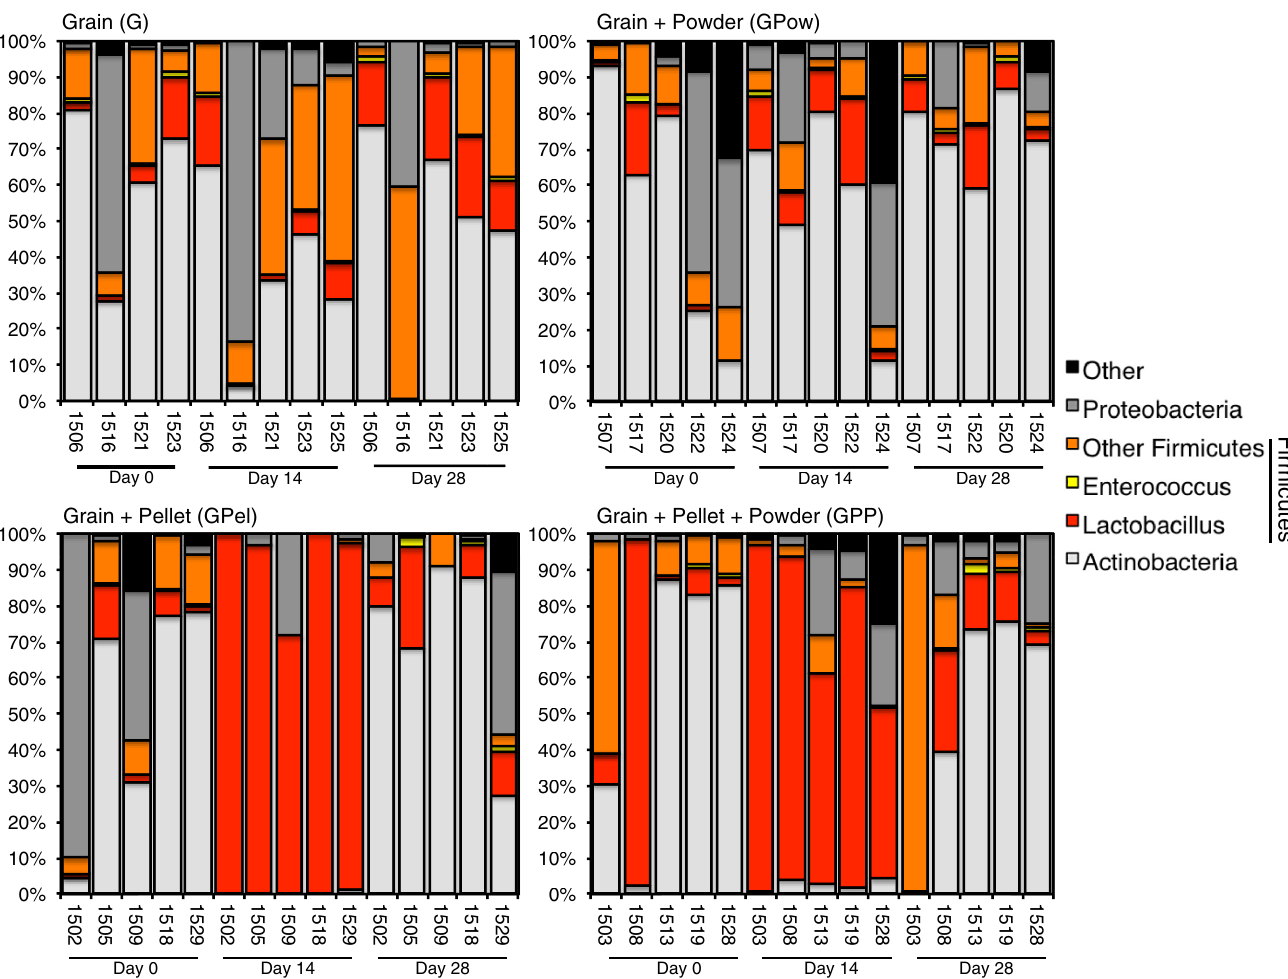
Fig 2. Relative bacterial phylum abundance in feces of pigeons before treatment (Day 0), on the last day of treatment (Day 14), and 14 days post-treatment (Day 28). Numbers on the x-axis represent pigeon ID. The Firmicutes phylum is depicted on a genus level. Relative abundances of five genera were significantly different from the control during the treatment period (Fig 3). Two of these genera include known human pathogenic species ( Pep- tostreptococcus and Corynebacterium ) [46,47], and two genera include species with known benefit to humans and birds ( Lactobacillus and Veillonella ) [46–49]. The function of the Ato- pobium genus is not known, but Atopodium spp. have been identified in the chicken gut microbiome [50]. Peptostreptococcus relative abundance was significantly lower than the Grain control in the GPP treatment at day 5 (p = 0.031), and in the GPel and GPP treatment on day 15 (p = 0.005; p = 0.007). Corynebacterium relative abundance was significantly lower than the control in the GPel and GPP treatments at day 5 (p = 0.013; p = 0.008), and in the GPP treat- ment at day 15 (p = 0.05). Lactobacillus relative abundance was significantly higher than the control in the GPel treatment at day 15 (p = 0.009), and Veillonella abundance was signifi- cantly lower in the GPel and GPP treatments at day 23. Last, Atopobium relative abundance in the GPel treatment was significantly decreased compared to the control (G; p = 0.027) on day 15, which was the day after treatment ceased.